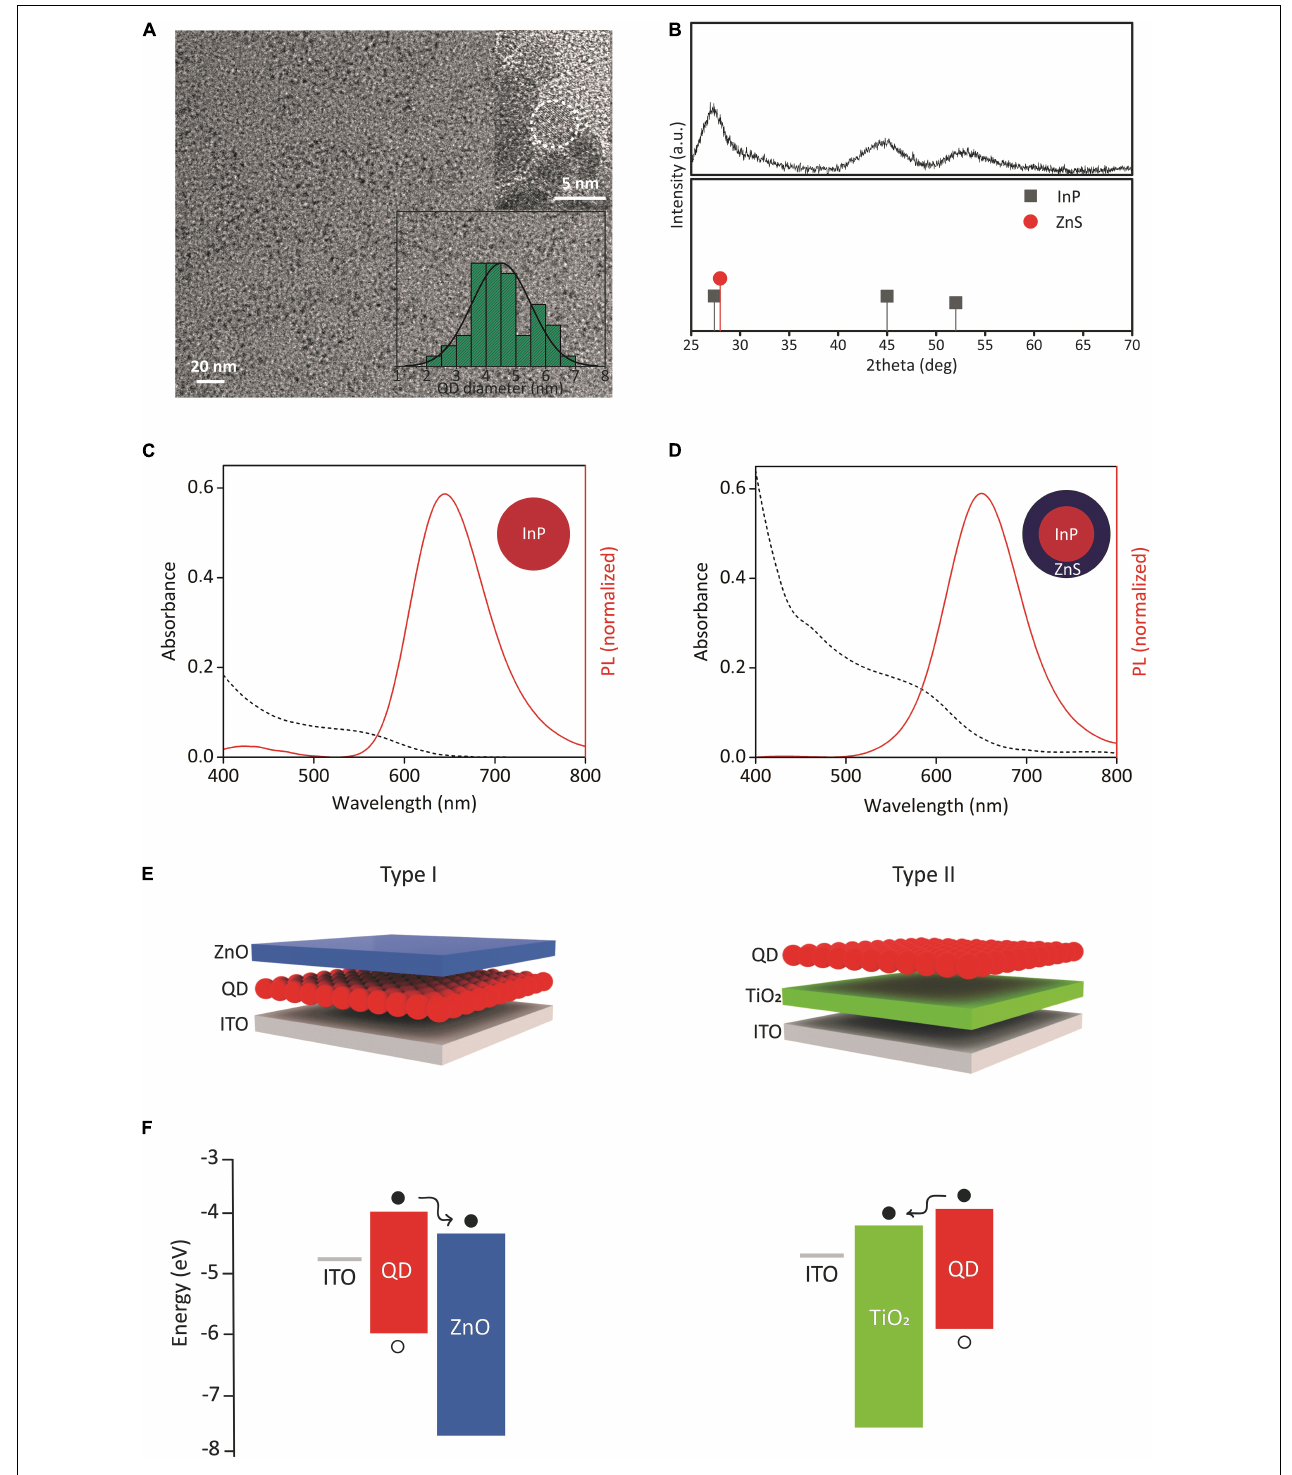
FIGURE 1 | Structural and optical properties of QDs, device structures, and energy diagrams. (A) TEM image of InP/ZnS core/shell QDs. Inset shows the corresponding size distribution and HRTEM image. (B) XRD pattern of InP/ZnS core/shell QDs. The XRD peak positions of zinc blende bulk InP (JCPDS No. 32-0452) and bulk ZnS (JCPDS No. 80-0020) were shown. (C,D) Absorption and emission spectrum of InP core and InP/ZnS core/shell QDs, respectively. (E) (Left) type I and (right) type II biointerface configurations. Either InP core or InP/ZnS core/shell QDs were used as QD layer. (F) Energy band diagrams of (left) type I and (right) type II biointerfaces. The energy levels were taken from our previous study and literature (Pattantyus-Abraham et al., 2010; Yang et al., 2012; Karatum et al., 2019). The displacement of electrons (filled circles) and holes (empty circles) was shown.